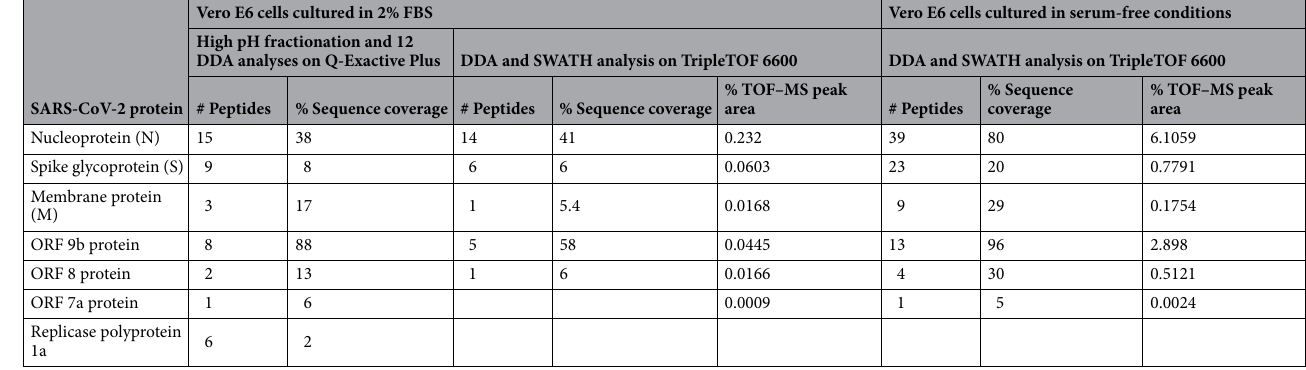
Table 1. Performance comparison of peptide discovery methods in various cell culture